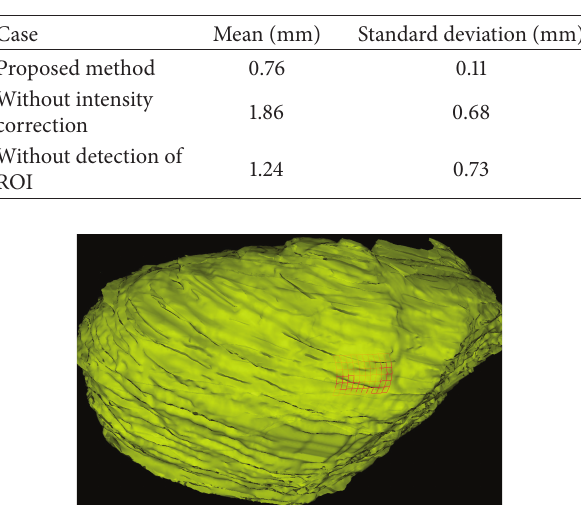
Figure 12: Overlay of 3D liver phantom surfaces after registration. Red mesh: reconstructed from endoscopic images, yellow surface: from MR